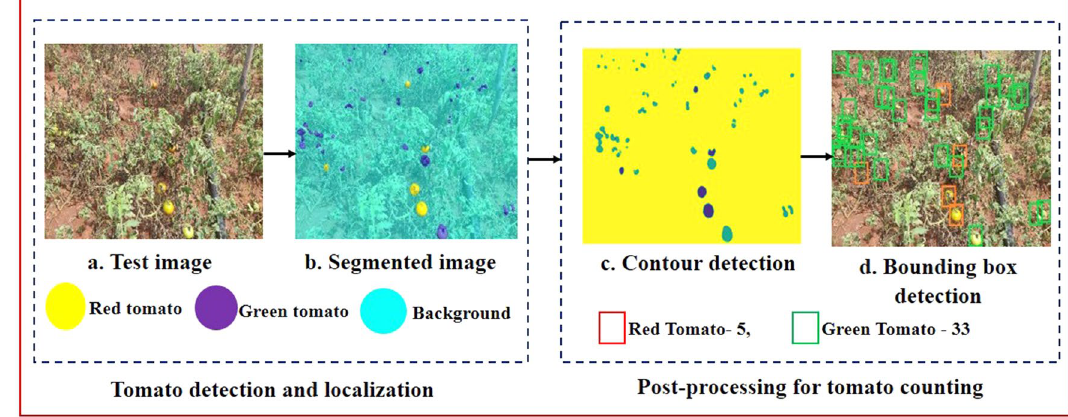
Figure 6. Test image tomato detection and counting using trained SegNet with VGG19 architecture.